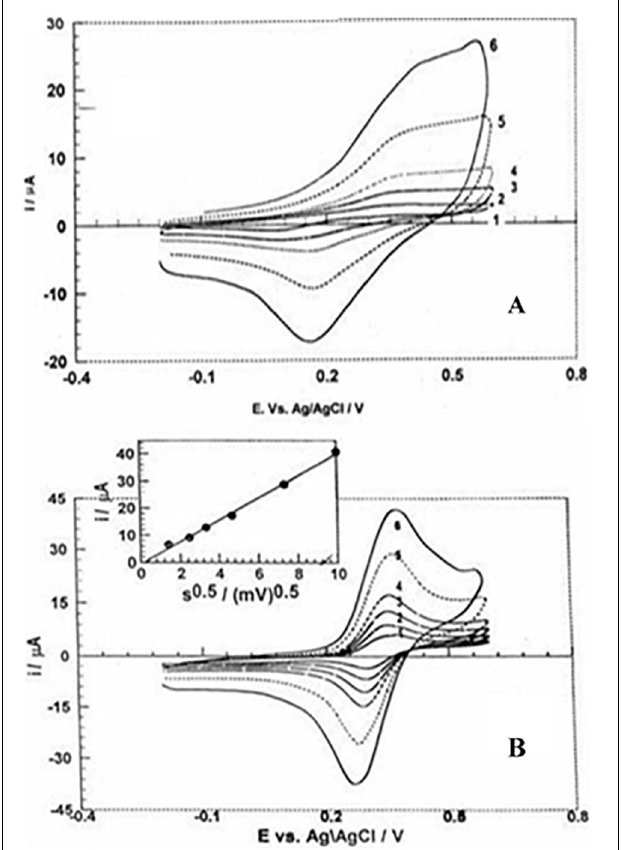
FIGURE 2 | Cyclic voltammograms of ferrocene monocarboxylic acid at different scan rates within an organically modified silicate electrode made without (A) and with (B) -Pd-C- and -Pd-Si- linked